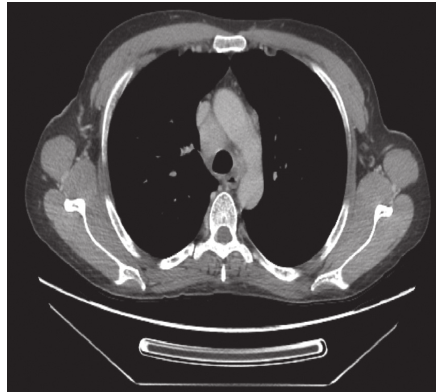
Figure 2: A CT scan of the chest (mediastinal window) showing enlarged right paratracheal lymph node measuring 18mm in short axis.